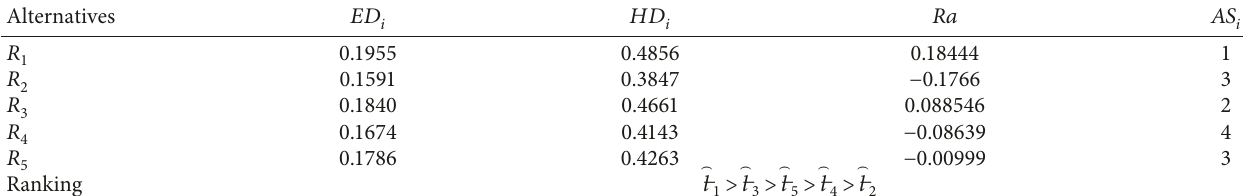
Table 7: The table represents the numerical data calculated by steps 4–7 for different values of q. Alternatives